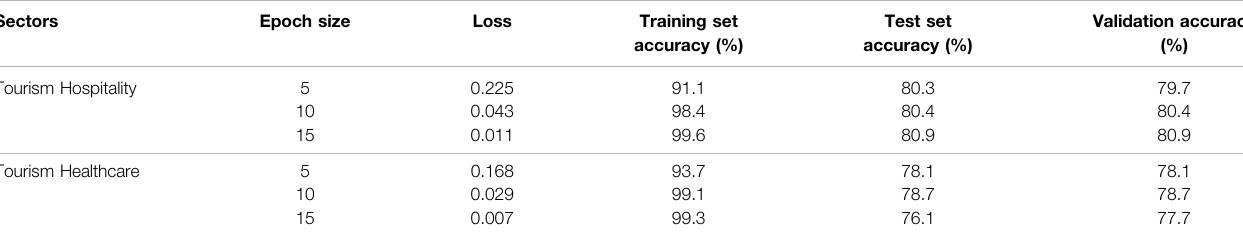
TABLE 1 | Comparison of LSTM RNN Model Based on Epoch size.